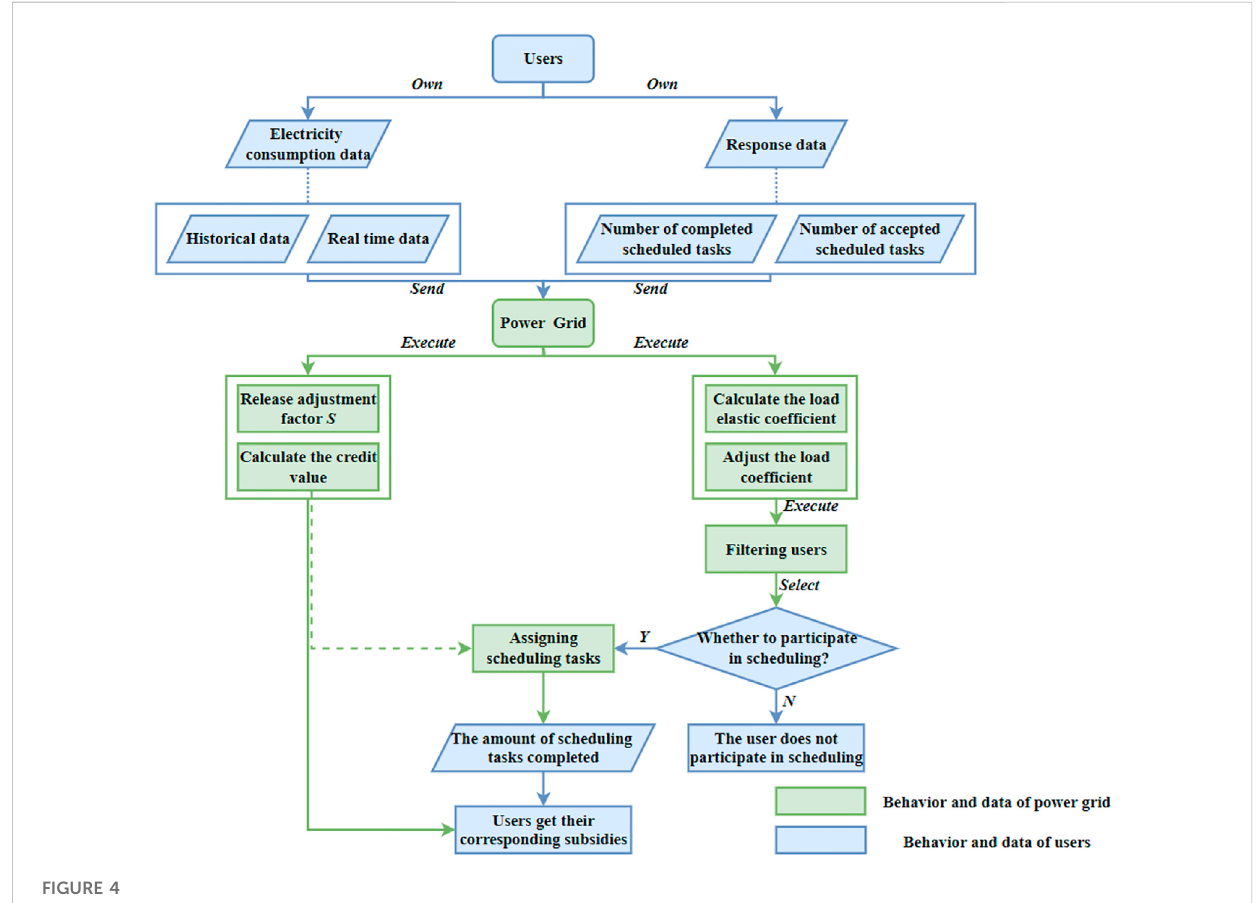
FIGURE 4 The process of user electricity